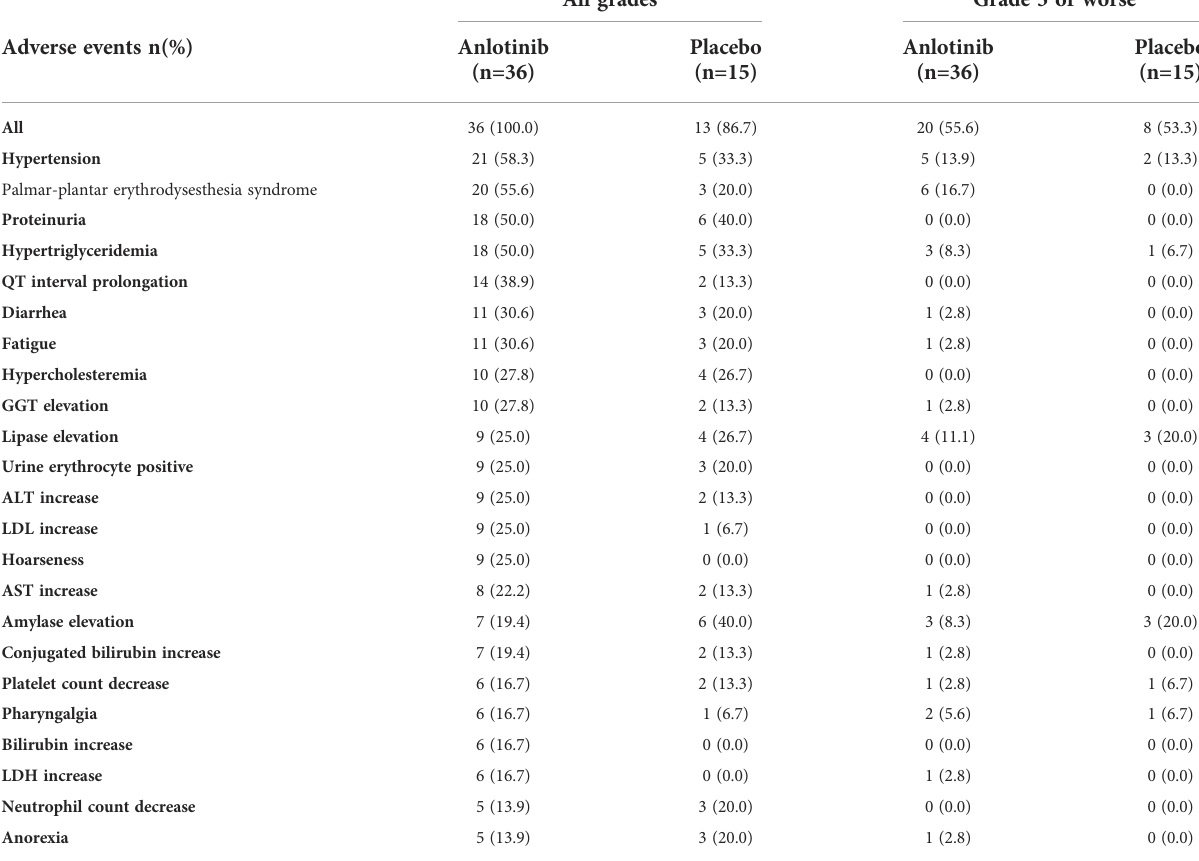
TABLE 2 Common treatment-related adverse events ( ≥ 20%) occurred in patients older than 50